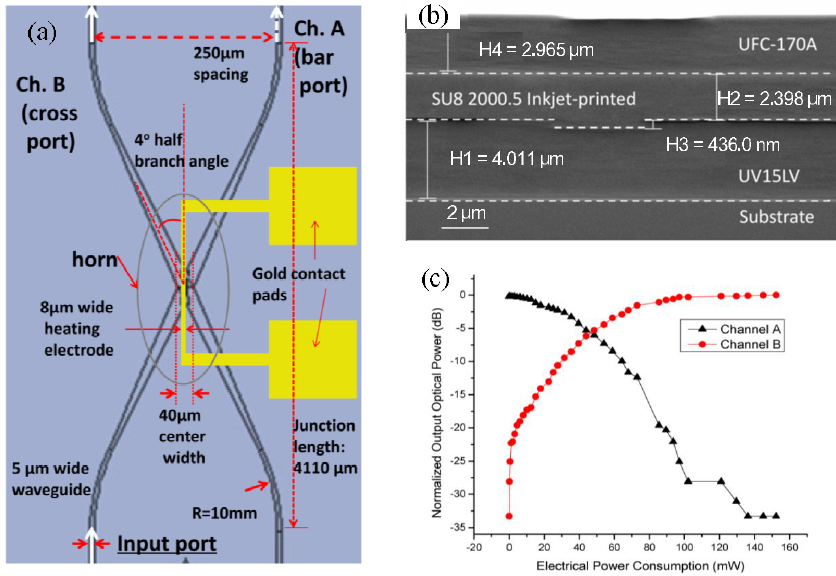
Figure 20. ( a ) Schematic showing the top view of the 2 × 2 TO TIR switch layout; ( b ) SEM cross-section view of printed layers in the TO polymer switch; ( c ) normalized optical output power versus electrical power from both bar port (Channel A) and cross port (Channel B) [46]. Copyright 2013 OSA.